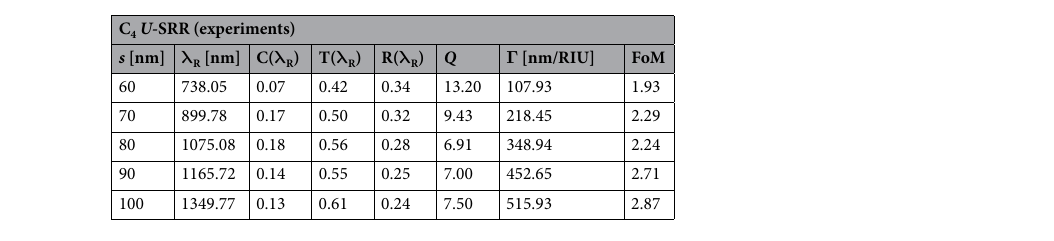
Table 1. Sensing parameters of C 4